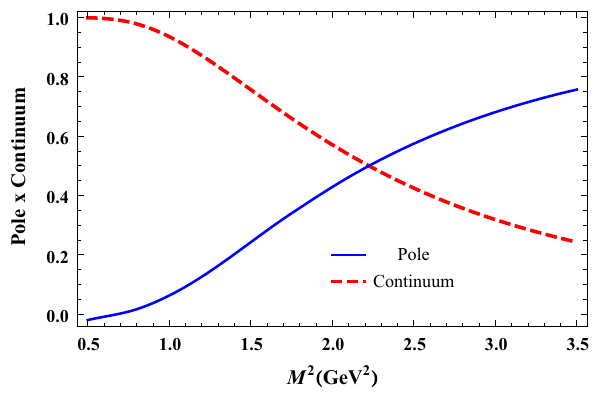
Fig. 1 Relative contributions of the pole (red-dashed) and contin- uum (blue) versus to the Borel parameter M 2 at s 0 = 5 . 95 GeV 2 for ρ ( 1940 ) at T = 0 2 Table 2 Borel and continuum threshold parameters working regions ( ∗ ) ( ∗ ) for the ρ and ω taking into account “PDG” data 2 2 Parameter